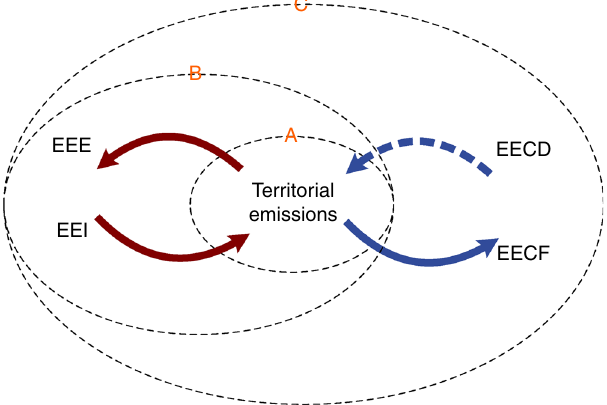
Fig. 1 Conceptual illustration of embodied emissions fl ows associated with emissions accounting. EEE represents emissions embodied in export, EEI represents emissions embodied in import, EECF represents emissions embodied in capital formation, and EECD represents emissions embodied in capital depreciation (utilization). Circle A indicates the scope of production- based accounting, which covers emissions within the targeted region during the targeted year. Circle B indicates the scope of traditional CBA, which covers emissions within and without the targeted region during the targeted year. Circle C indicates the scope of dynamic CBA, which covers emissions within and without the targeted region before and during the targeted year. The traditional footprint is calculated as territorial emissions plus EEI less EEE, while the dynamic footprint is calculated as territorial emissions plus EEI and EECD less EEE and EECF. Note that the sizes of the three circles do not necessary represent the relative value of the